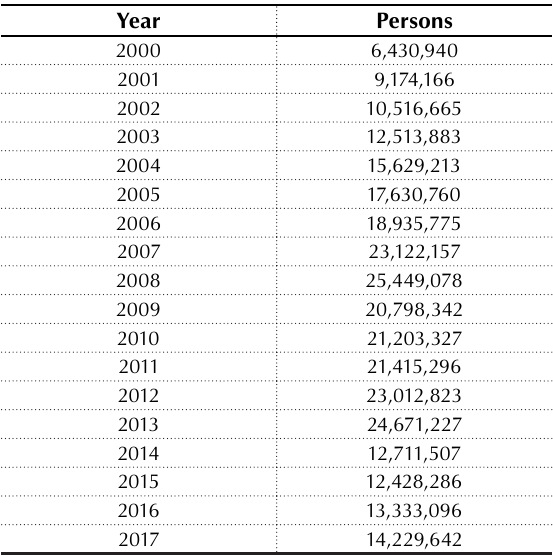
Table 4. Indicators of tourist arrivals in Ukraine, 2000–2017